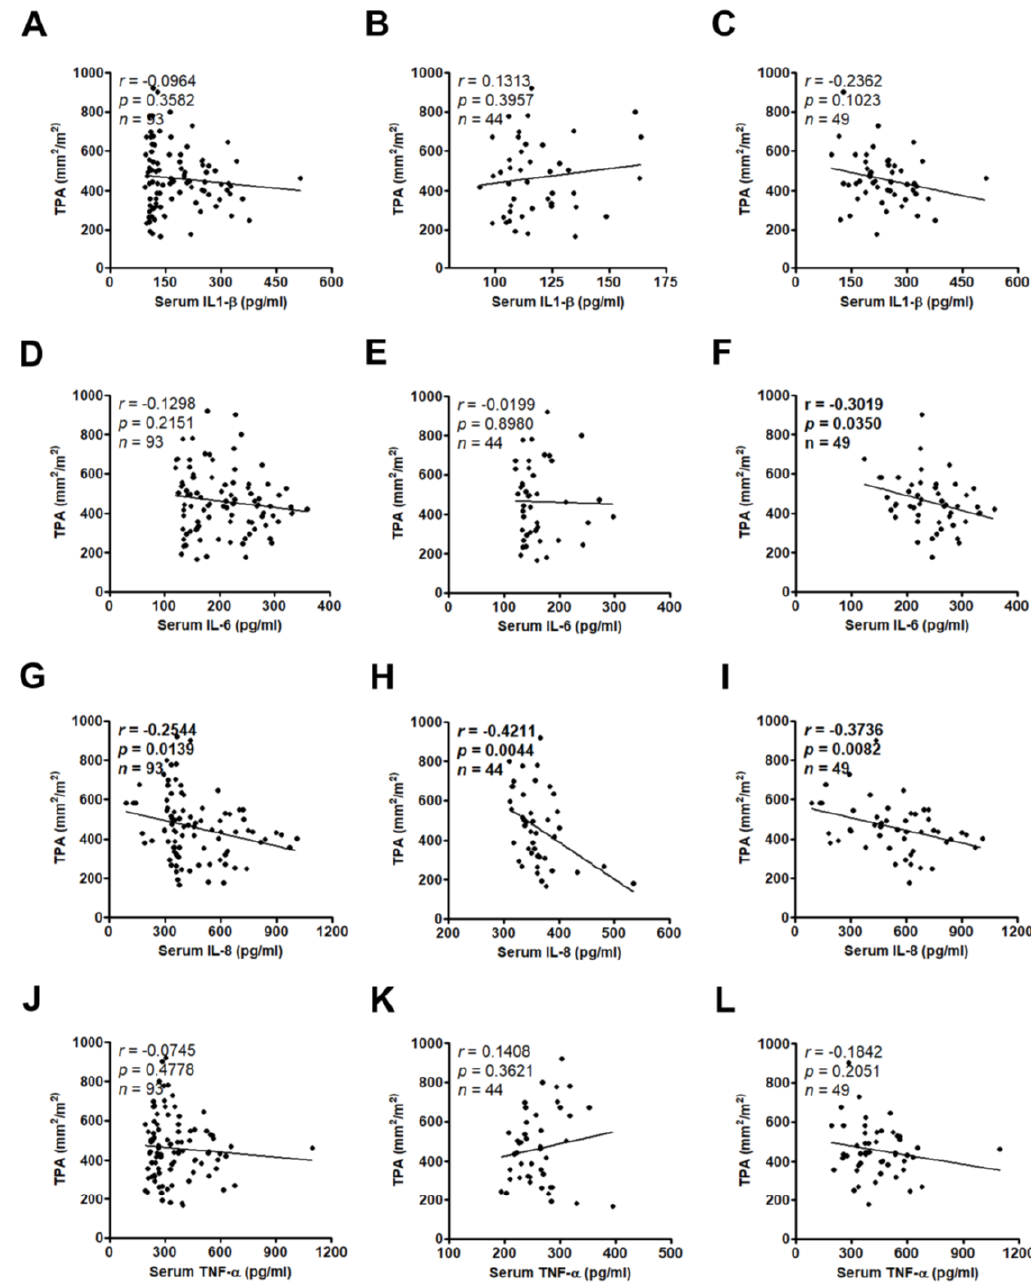
Figure 7. The correlation between IL-1β, IL-6, IL-8, or TNF-α serum concentration from all patients ( A , D , G , and J ), the resected group ( B , E , H , and K ), or the locally advanced group ( C , F , I , and L ) and total psoas area was analyzed by Pearson’s correlation analysis. The bold value indicates p < 0.05. TPA, total psoas